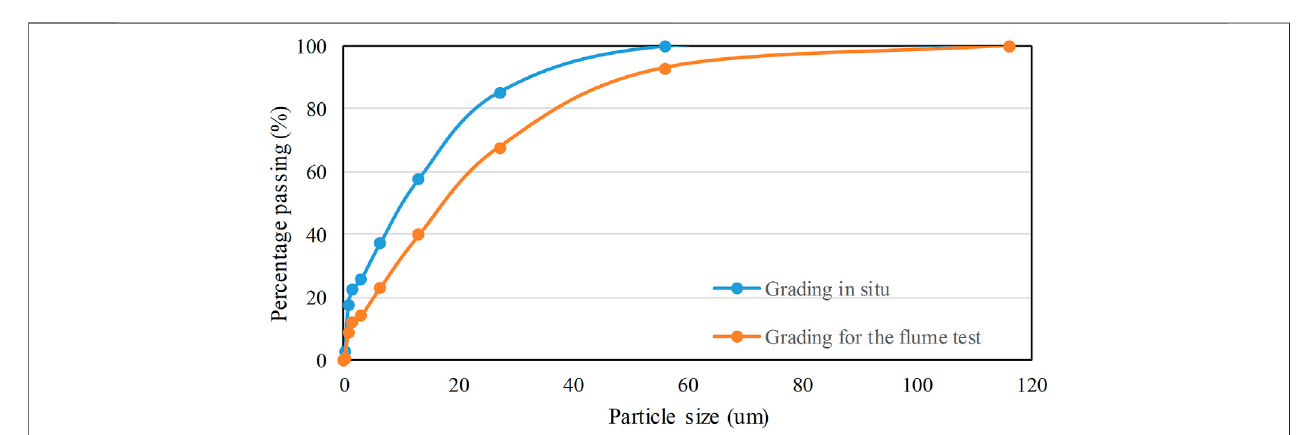
FIGURE 4 | The grading of the in situ soil and the material used for the fl ume test.